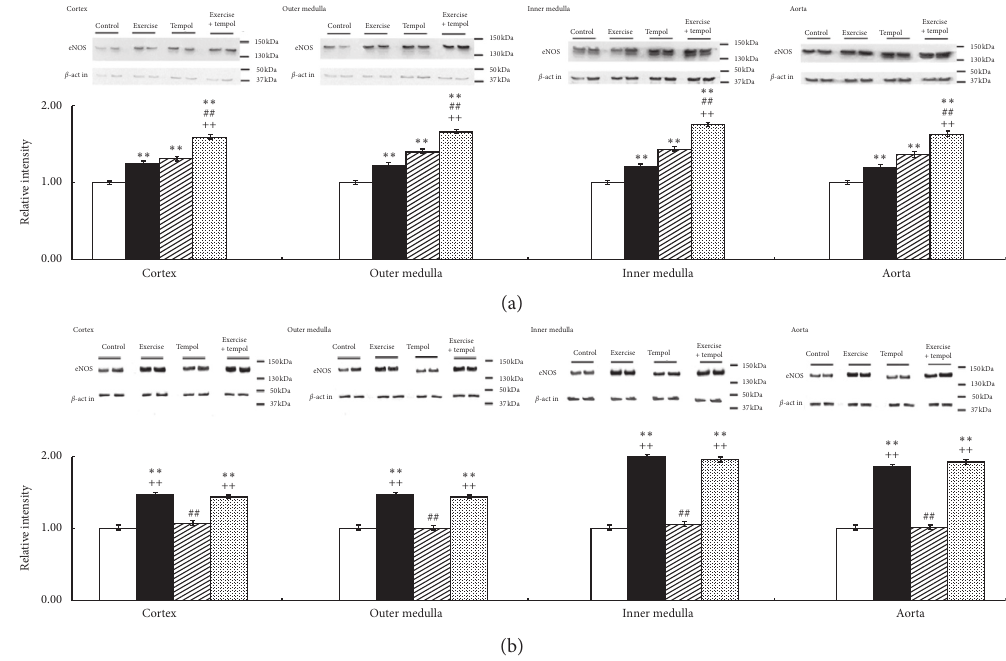
Figure 6: Effects of Ex and tempol on the protein levels of eNOS in SHR and WKY. The protein levels of eNOS in the renal cortex, outer medulla, inner medulla, and aorta of SHR (a) and WKY (b) were compared among the control group (open bars), Ex group (closed bars), Tmp group (hatched bars), and Ex +Tmp group (checked bars) ( n � 10 in each group). Top panel shows representative immunoblots of eNOS, middle panel shows the immunoblots of β -actins, and bottom panel shows data of the densitometric analysis. ∗ P < 0 . 05 vs. the control group. ∗∗ P < 0 . 01 vs. the control group. ## P < 0 . 01 vs. the Ex group. ++ P < 0 . 01 vs. the Tmp